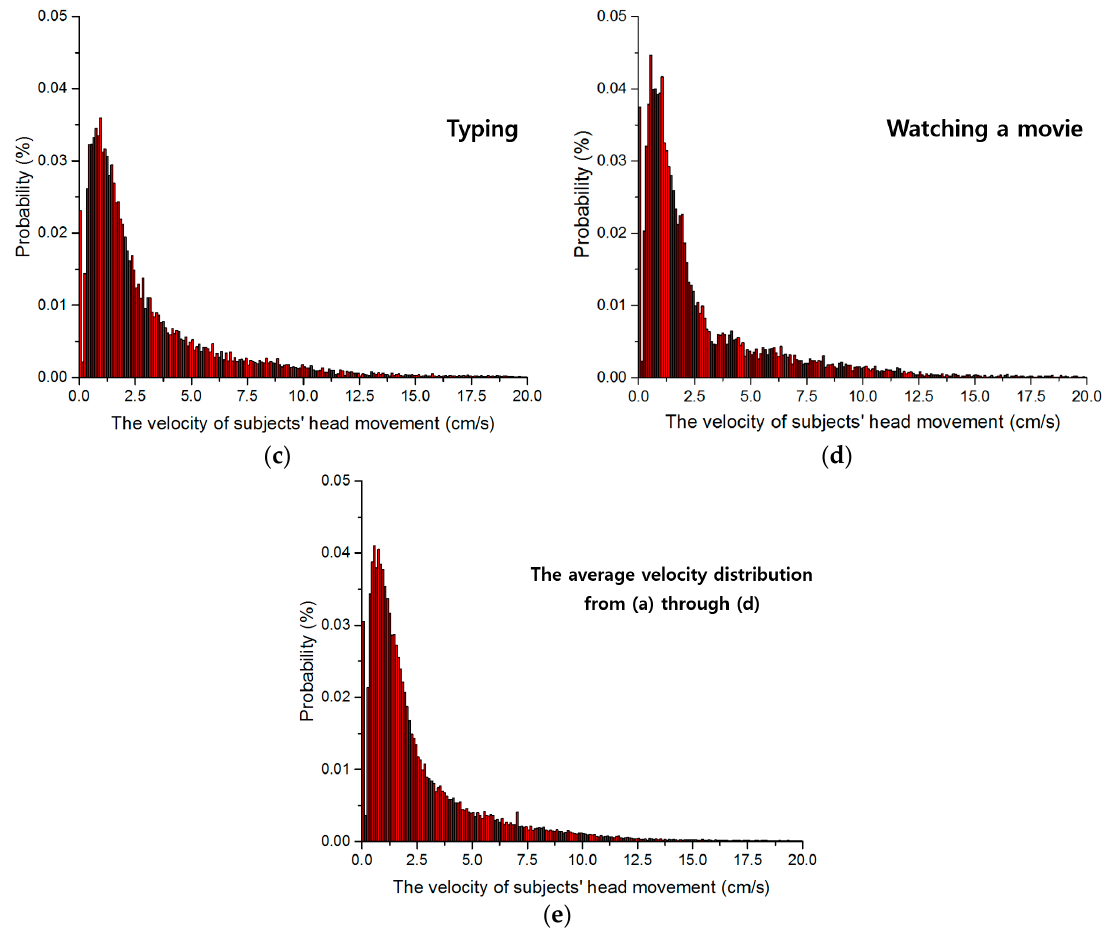
Figure 10. Subjects’ head movement velocities in 3D space while: ( a ) playing a game; ( b ) surfing the web; ( c ) typing; and ( d ) watching a movie; ( e ) The average velocity distribution from ( a ) to ( d ).